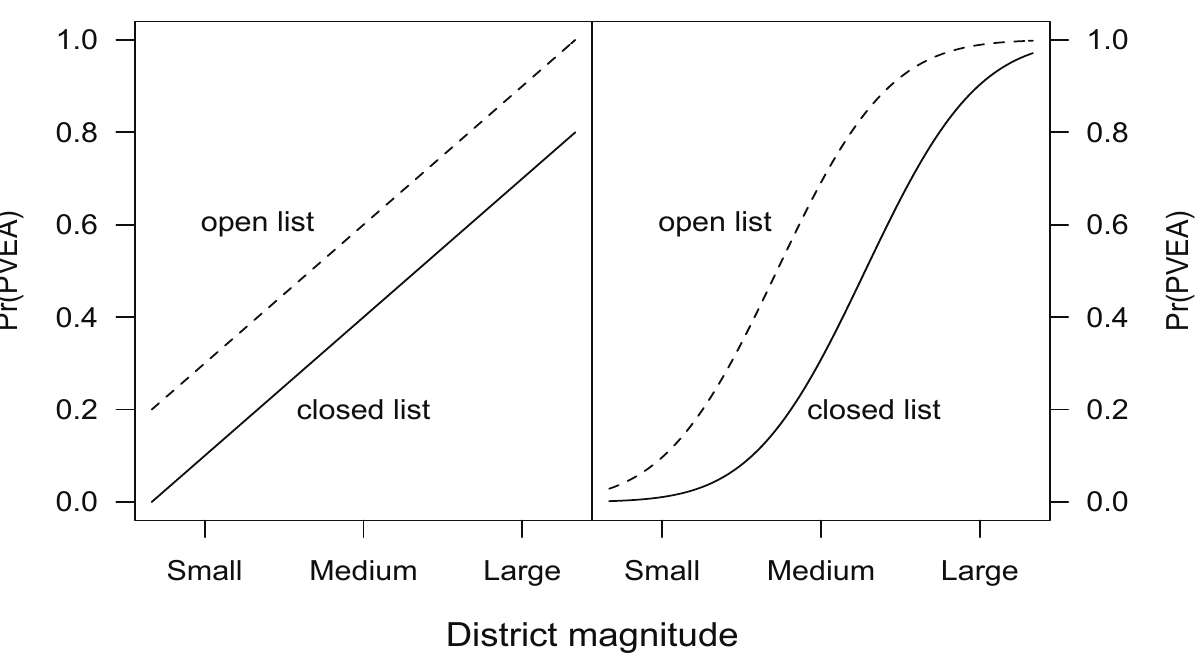
Figure 1. Probability models for personal vote-earning attributes. The left panel displays a standard linear model and the right panel displays a probit